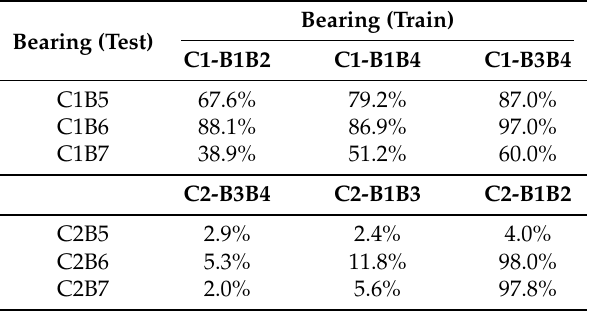
Table 4. FPT to total duration ratio in different training data variation in CNN-HS under conditions 1 and 2.